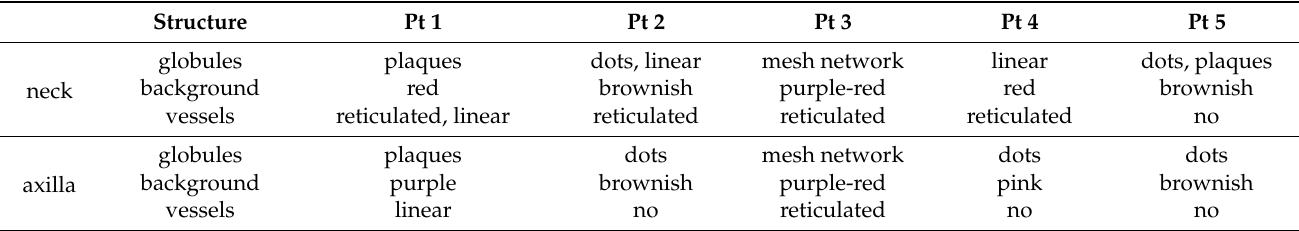
Table 3. Characteristic dermoscopic features of the affected skin sites of the pseudoxanthoma elasticum patients according to the nomenclature of Berthin et al. [15] and Kawashima et al. [17].